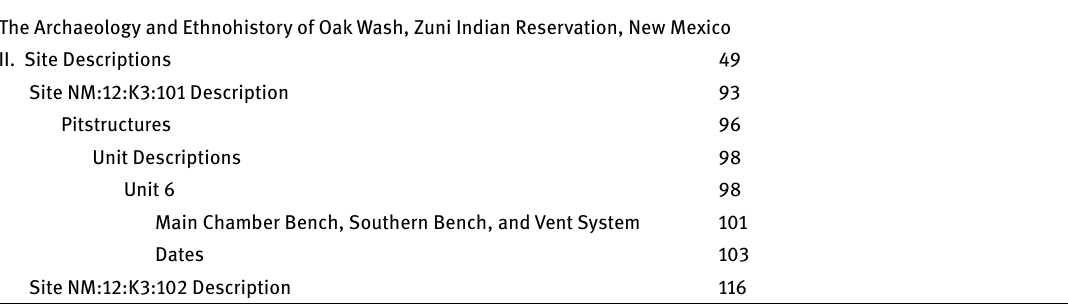
Figure 1: Sample Section of Report Text from Howell [12].